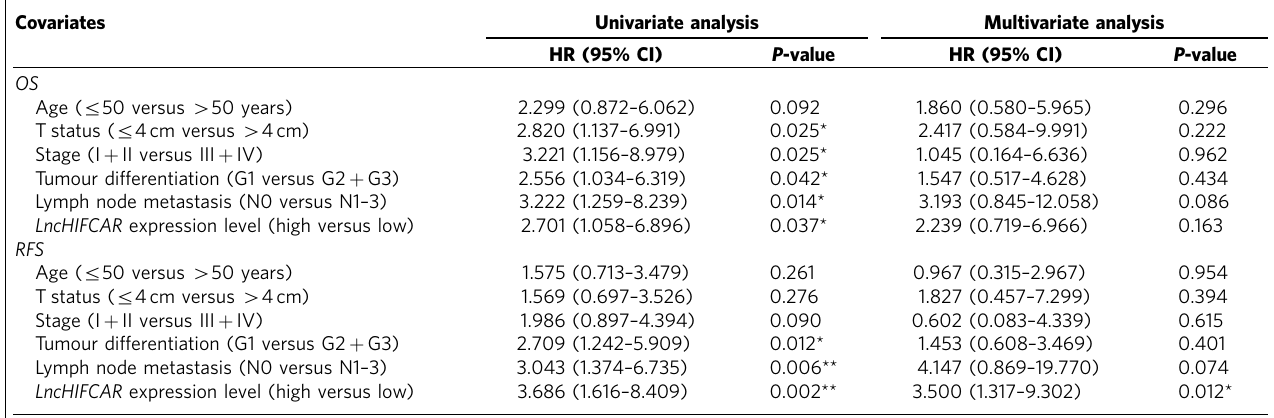
Table 1 | Univariate and multivariate Cox regression analyses of OS and RFS in OSCC patients.